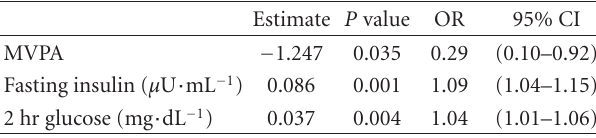
Figure 1: Mean ( ± SEM) values for the sedentary and MVPA indices and PE volume between obese children with (solid bars) and without (striped bars) insulin resistance. Table 3: Parameter estimates ∗ from the final logistic regression modeling ( N =